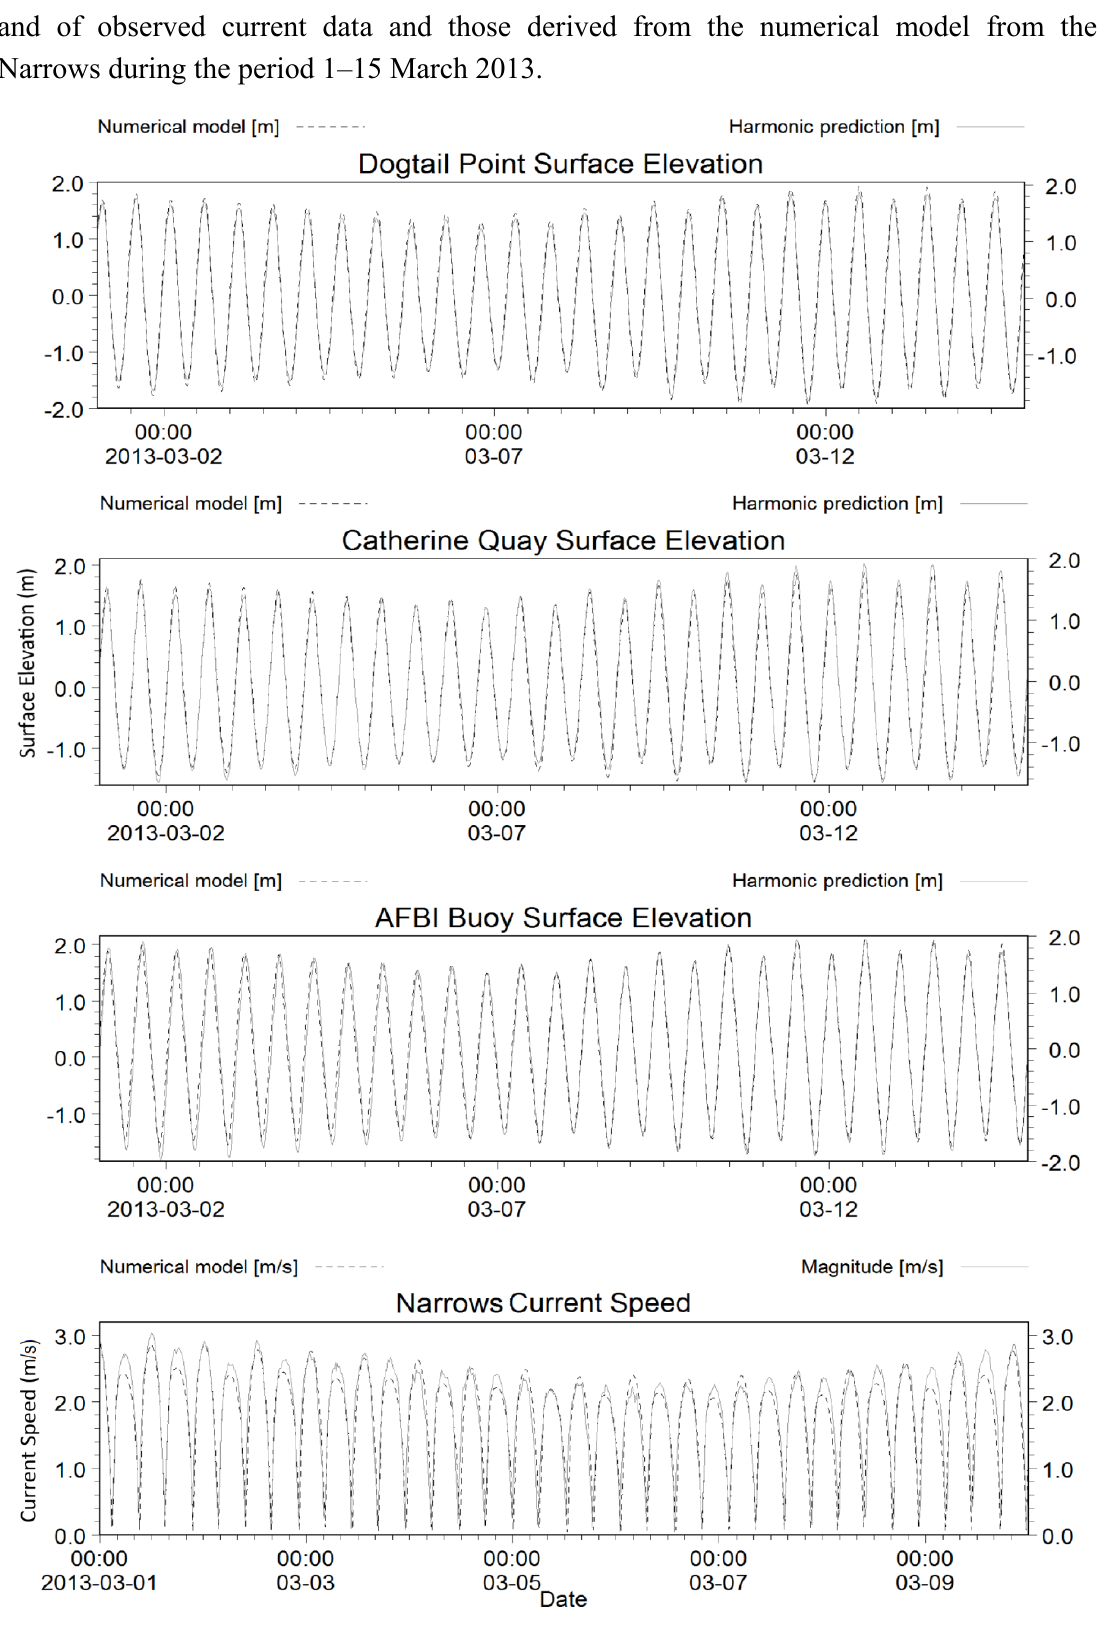
Figure 9. Comparison of surface elevation predictions derived from harmonically predicted data and numerical model at: Dogtail Point, Catherines Quay and AFBI Buoy and of observed current data and those derived from the numerical model from the Narrows during the period 1–15 March